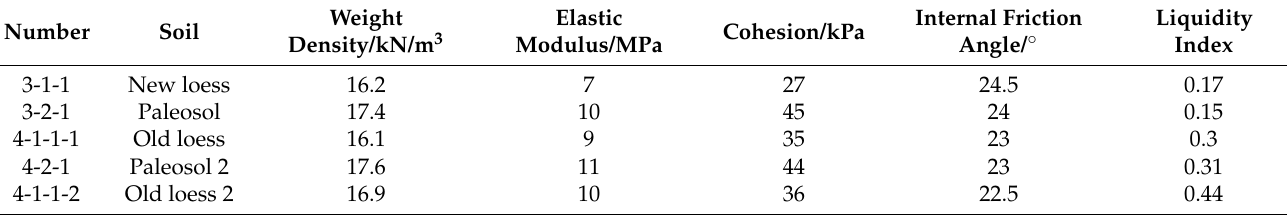
Table A1. Physico-mechanical properties of soil layer.